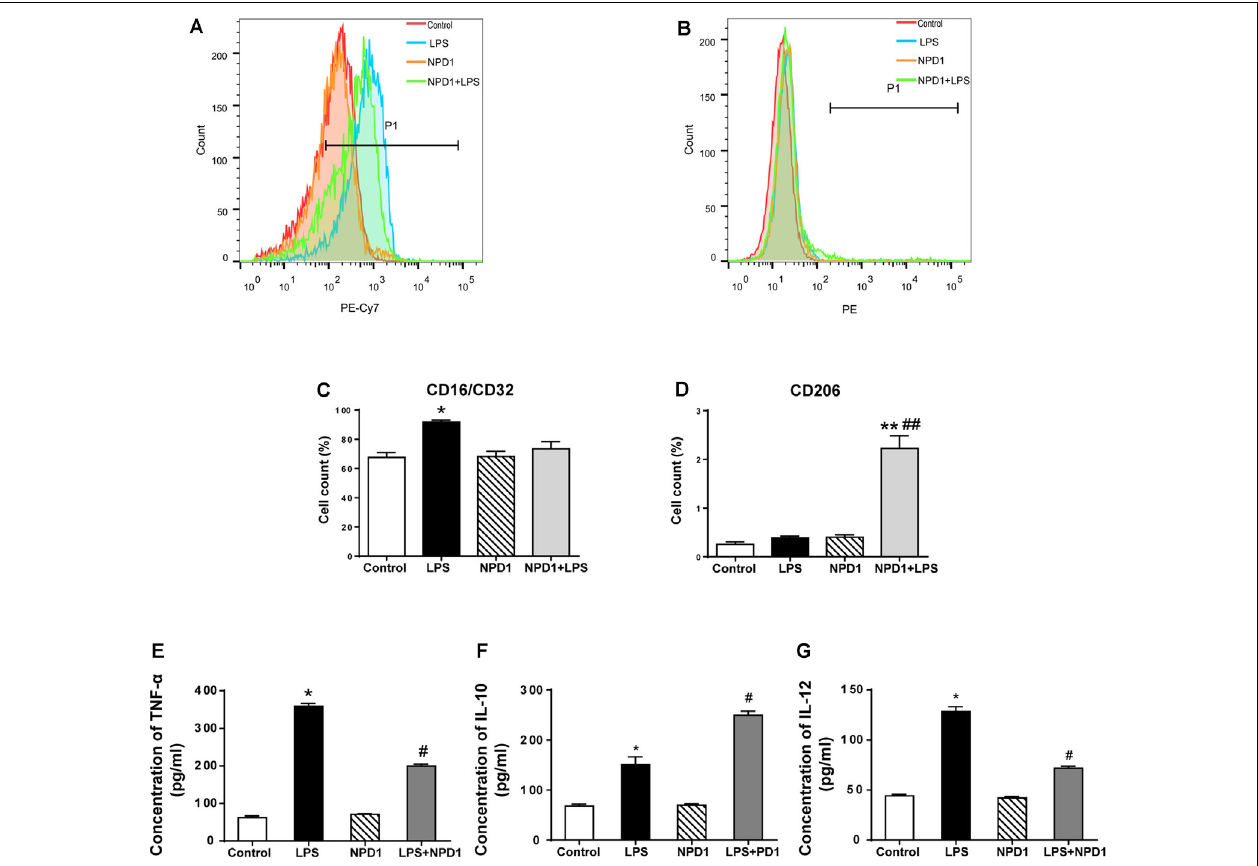
FIGURE 6 | NPD1 promotes macrophage polarization to the M2 phenotype after pro-inflammatory stimulation of BMDMs and modulates the expression of inflammatory cytokines. NPD1 promoted the transformation of BMDM cell markers from the M1 to M2 phenotypes, as detected by flow cytometry (A,B) . The ratios of M1 and M2 phenotypes in different groups were calculated (C,D) . The production of tumor necrosis factor- α (TNF- α ), interleukin (IL)-12, and IL-10 by BMDMs were tested by ELISA (E–G) . Data are presented as mean ± SEM. Statistics: two-way ANOVA followed by Bonferroni post hoc comparison. (A–G) n = 5 per group. * P < 0.05 vs. the control group, ** P < 0.01 vs. the control group, # P < 0.05 vs. the surgery group, ## P < 0.01 vs. the surgery